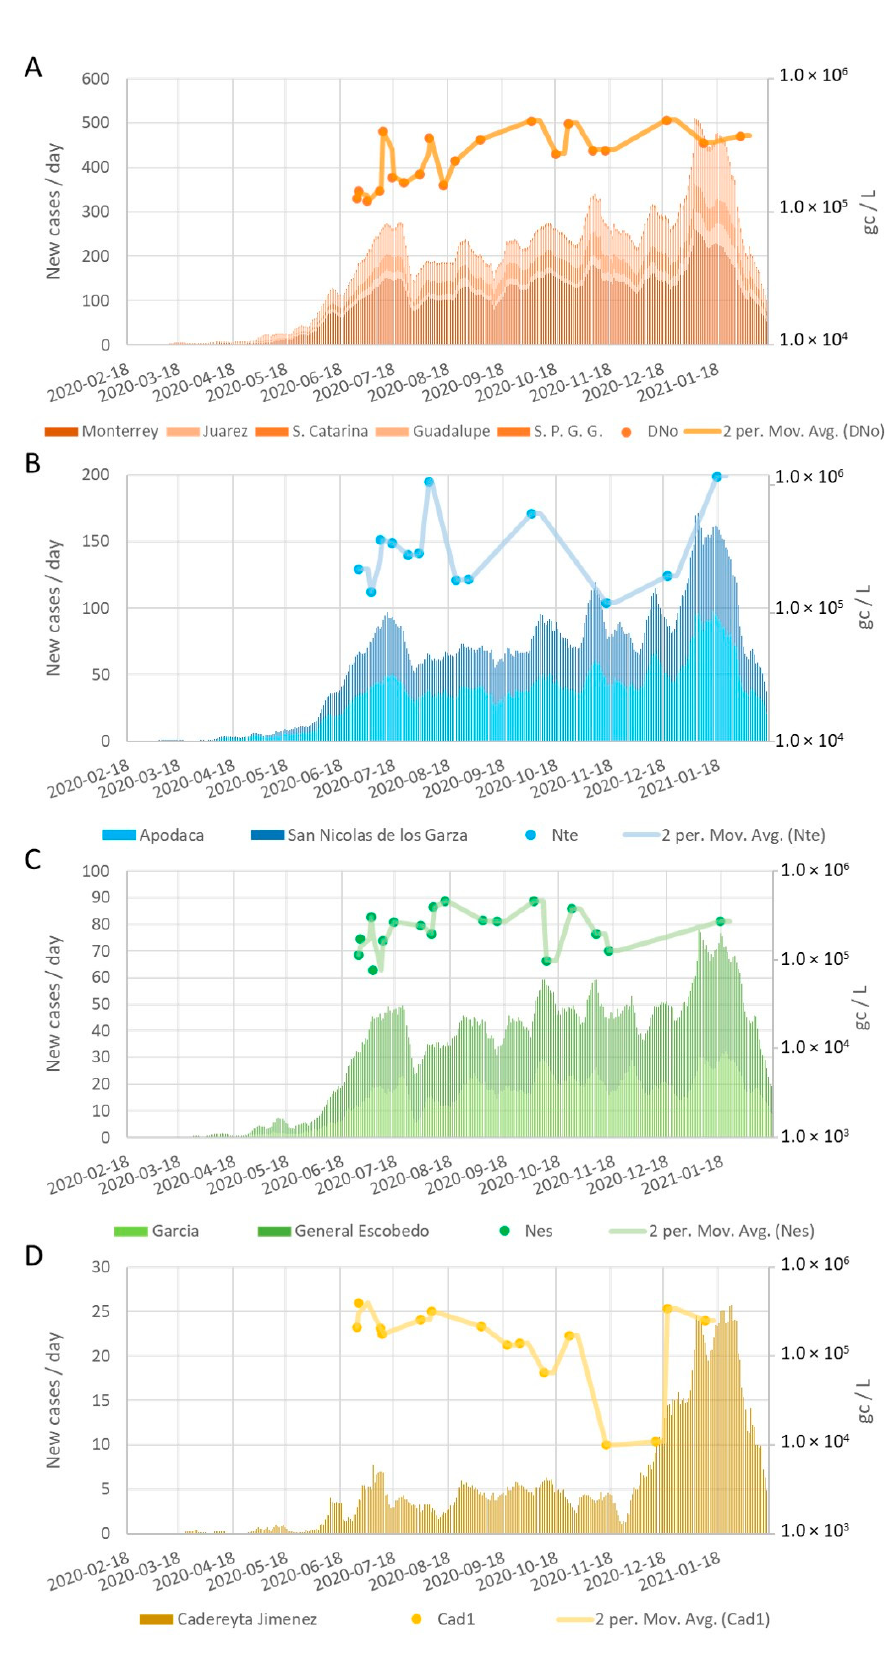
Figure 3. New cases per municipality associated with WWTPs that serve the Monterrey metropolitan area vs. geneticcopiesperliterineachWWTP:( A )DulcesNombres, ( B )Norte, ( C )Noreste, and( D